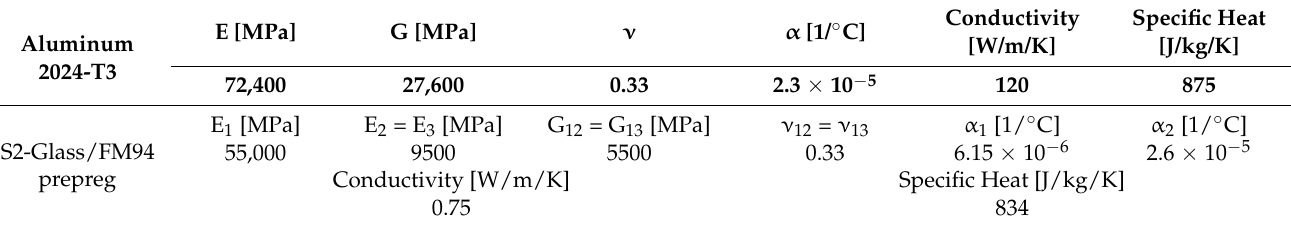
Table 1. Material parameters for GLARE constituents.